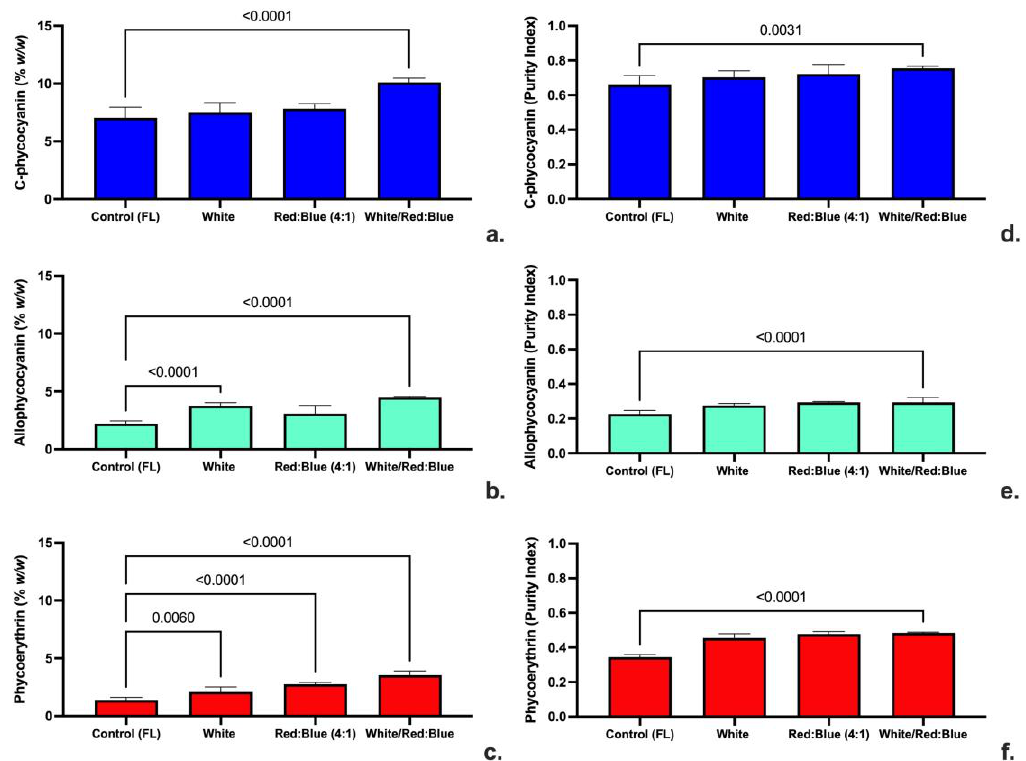
Figure 3. The concentration of phycocyanin (C-PC) ( a ), allophycocyanin (APC) ( b ), and phycoerythrin (PE) ( c ) and their purity ( d – f ) under different LEDs configurations.